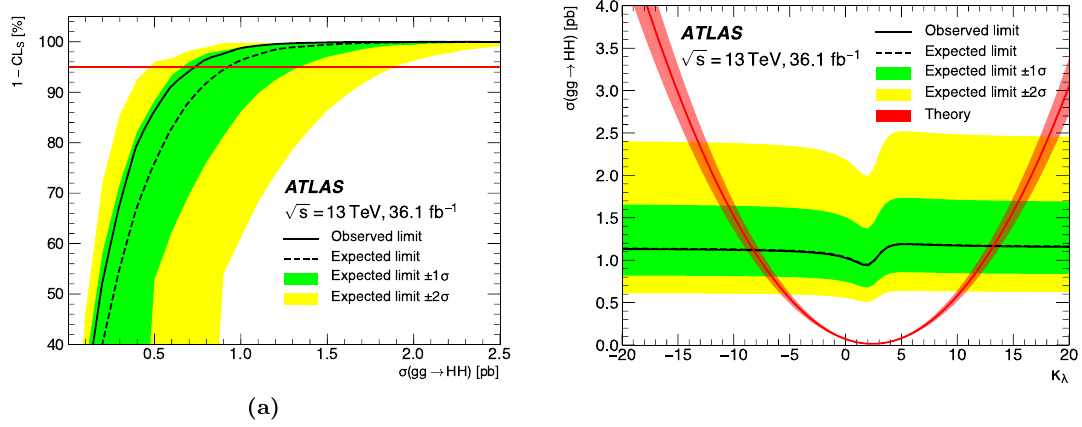
Figure 6. The expected and observed 95% CL limits on the non-resonant production cross-section (cid:27) gg ! HH (a) for the SM-optimised limit using the tight selection and (b) as a function of (cid:20) (cid:21) using the loose selection. In (a) the red line indicates the 95% con(cid:12)dence level. The intersection of this line with the observed, expected, and (cid:6) 1 (cid:27) and (cid:6) 2 (cid:27) bands is the location of the limits. In (b) the red line indicates the predicted HH cross-section if (cid:20) (cid:21) is varied but all other couplings remain at their SM values. The red band indicates the theoretical uncertainty of this